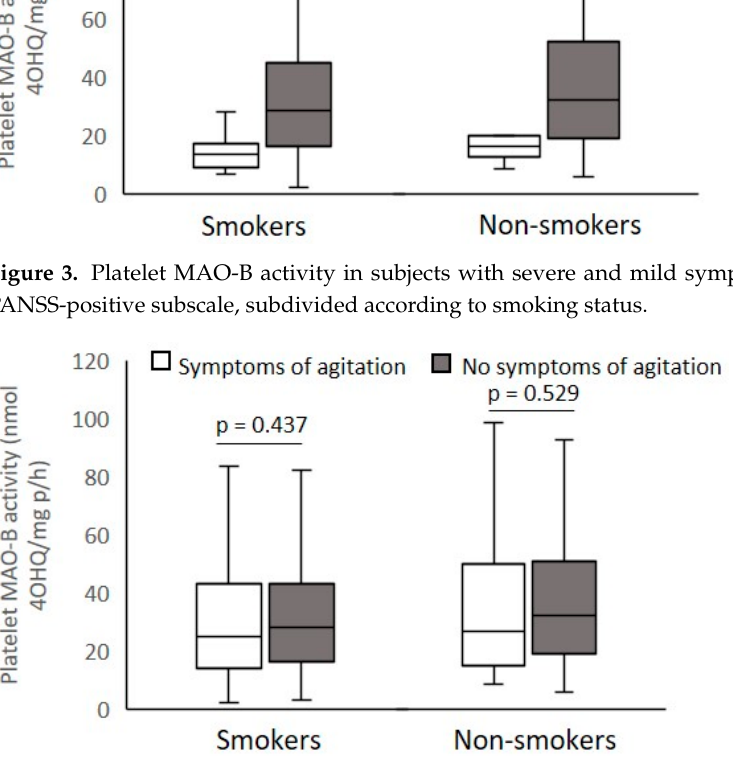
Figure 4. Platelet MAO-B activity in subjects with severe and mild symptoms evaluated by the PANSS-excitement subscale, subdivided according to smoking status.